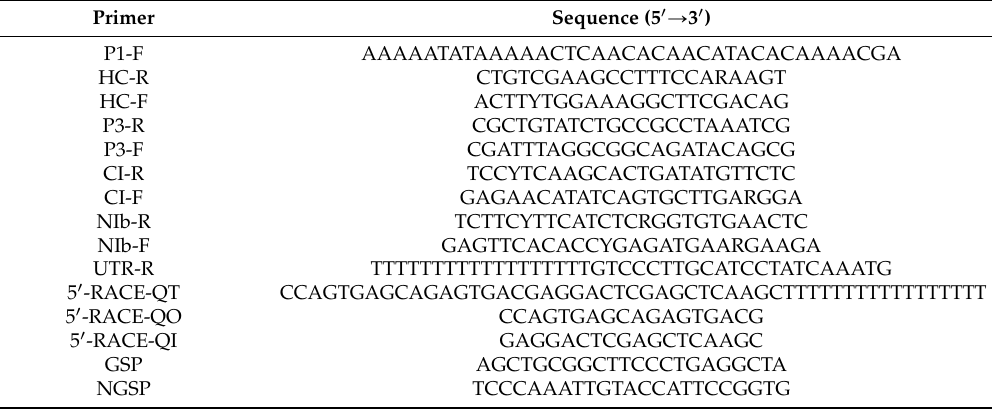
Table 7. Primers used for amplifying the complete genomic sequences of